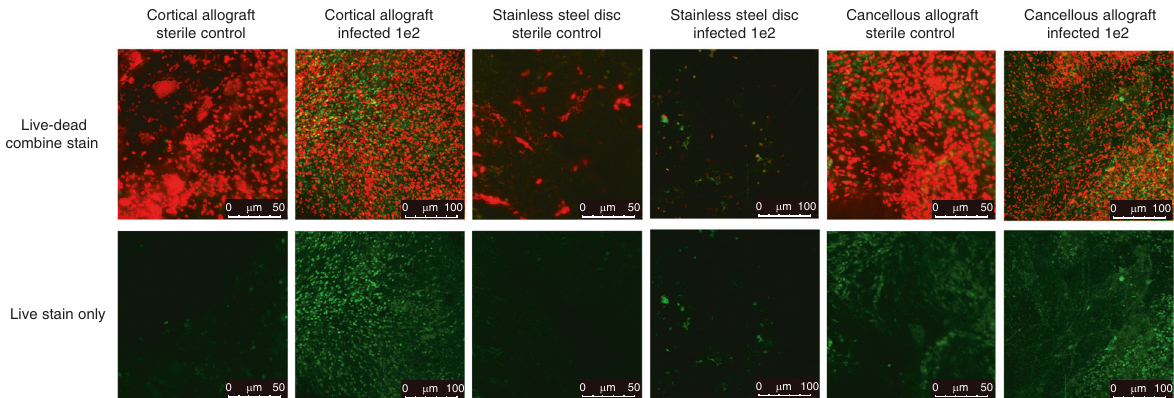
Fig. 5 Live – dead confocal microscopy. Confocal fl uorescent microscopy of cortical allograft, stainless steel disc, or cancellous allograft at POD 56 following inoculation with sterile saline, or 1 × 10 2 CFU of S. aureus Xen36, magni fi cation ×100. The commercially available Live/Dead BacLight Bacterial Viability Kit (Thermo Fischer Scienti fi c, Canoga Park, CA) was utilized. SYTO9 dye stains nucleic acids in intact cell membranes, representing live bacteria. Propidium iodide die stains nucleic acids in ruptured cell membranes, representing dead bacteria. The comparison of the live stain in the cortical allograft reveals qualitatively more green stain/100 μ m in the infected compared to the sterile group, whereas the live stains in the stainless steel and cancellous allograft appear more similar between infected and sterile groups. While the intent of the SYT09 dye is to stain microbial cells, host cells may represent a confounding factor and cautions the interpretation of this